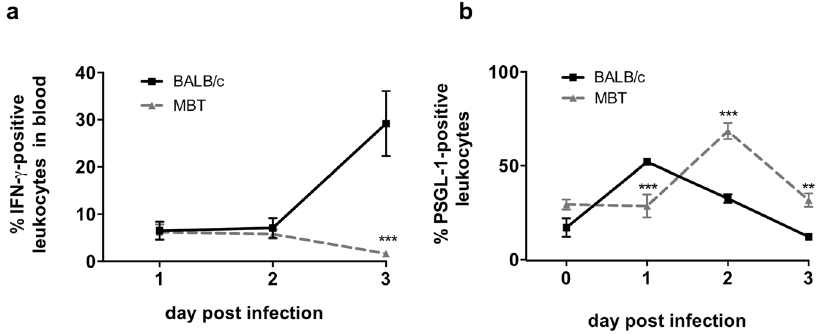
Figure 7. Delayed activation of circulating leukocytes in MBT mice. ( a) Percentages of circulating leukocytes expressing IFN- γ in BALB/c and MBT mice on days 1–3 post infection as evaluated by intracellular flow cytometry. (b) Percentages of PSGL-1-positive circulating leukocytes in BALB/c and MBT mice on days 0–3 post infection. Cytometry experiments were performed twice (n = 5 mice/strain/timepoint). Data are represented as mean ± SEM. Representative experiments are displayed. Two-way ANOVA was used to test differences between means. * P < 0.05, ** P < 0.01, and *** P <